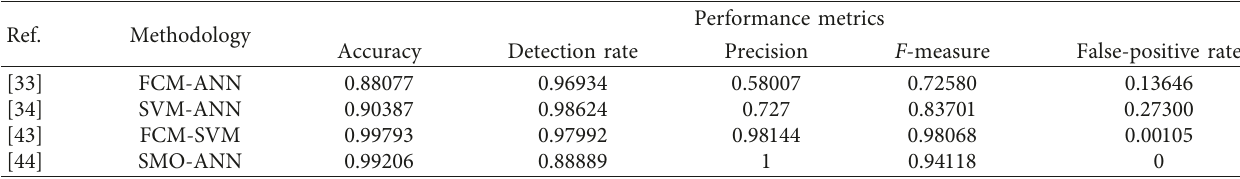
Table 7: Comparison of various methodologies based on different performance metrics for exploits attack. Ref.